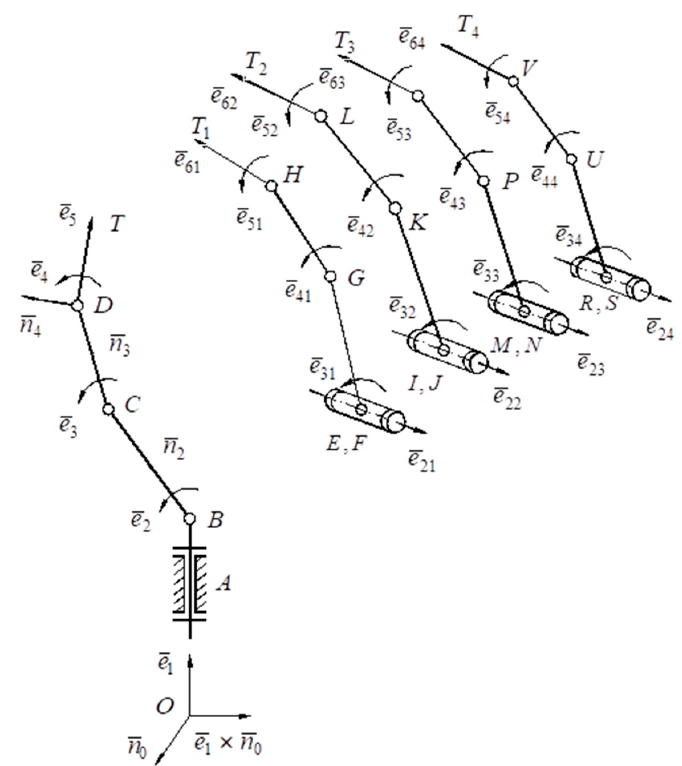
Figure 8. Kinematic scheme of the hand’s fingers’ mechanisms.